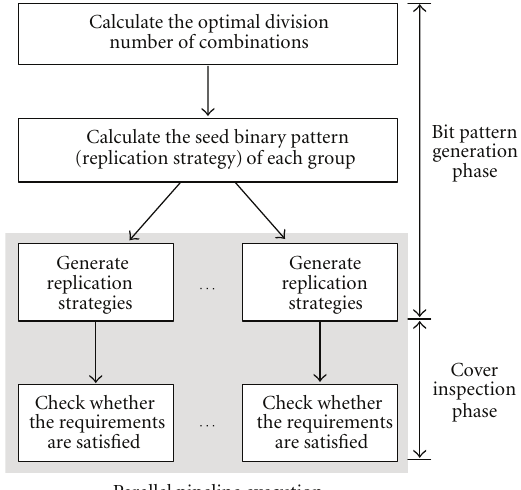
Figure 4: Overview of the proposed